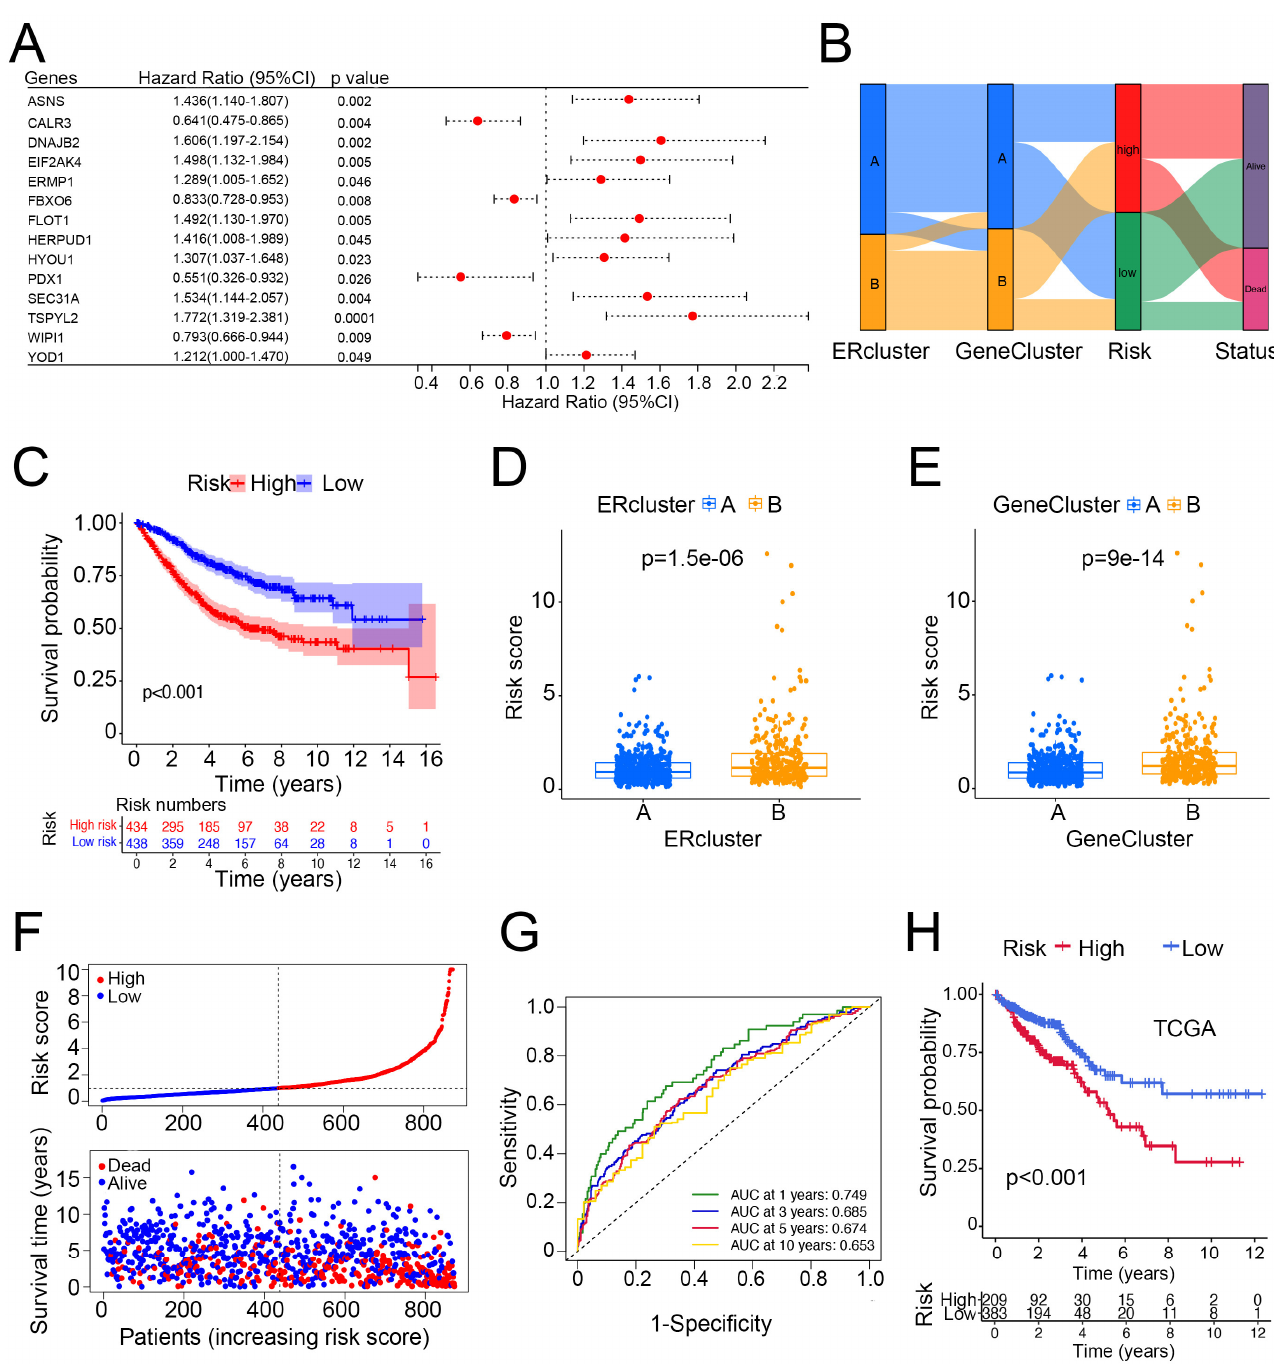
Figure 5. Construction of an ER stress-related risk score in predicting survival of patients with CRC. ( A ) Univariate Cox regression results of the 14 risk score-building genes in patients with CRC from GEO datasets. ( B ) Alluvial diagram of sub-cluster distributions with distinct risk score and clinical outcomes. ( C ) Survival analysis of the high- and low-risk group (log rank test p value < 0.001). ( D , E ) Difference of risk score in ERclusters and GeneClusters. ( F ) Ranked plots and distribution plots of risk score and clinical outcomes, respectively (median value of risk score was set as cutoff value). ( G ) ROC curves of the sensitivity and specificity of 1-, 3-, 5-, and 10-year survival prediction using risk score. ( H ) Validation of risk score in predicting TCGA COAD/READ survival ( n =